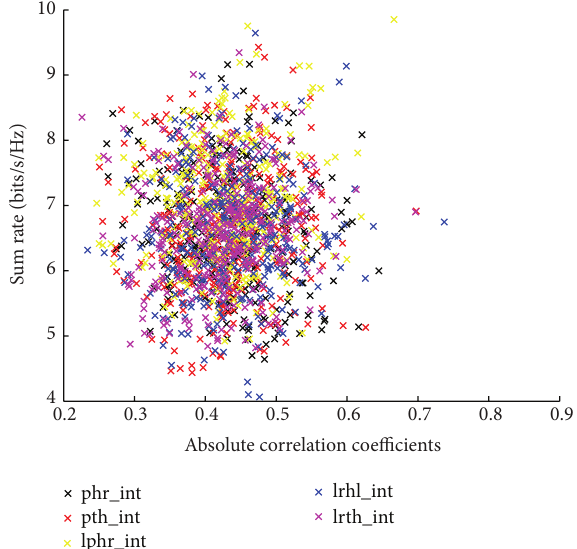
Figure 12: Scatter plot: capacity versus correlation for interference links at low